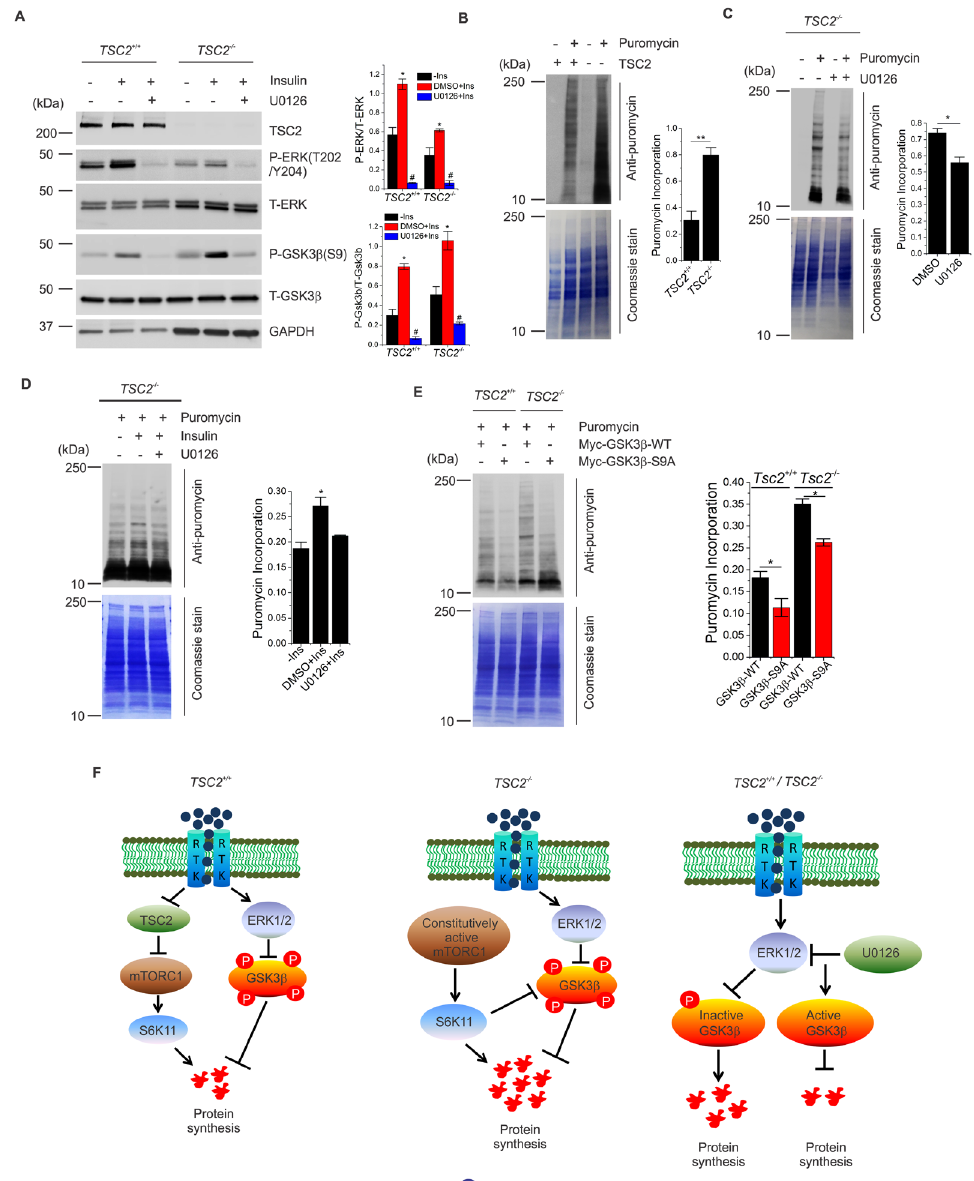
Figure 5. ERK restores GSK3 β activity and protein synthesis levels in Tsc2 − / − cells. ( A ) Tsc2 + / + and Tsc2 − / − MEFs were starved of serum (16 h) and treated with U0126 for 2 h prior to insulin stimulation (1 µ M, 15 min). Lysates were analyzed by immunoblot assay using antibodies as indicated. GAPDH was used as a loading control in all immunoblot assays. Quantification of three independent experiments is reported in the bar diagrams. * and # indicate significant differences between all conditions in each group. ( B ) Tsc2 + / + and Tsc2 − / − MEFs were grown 24 h followed by treatment with puromycin for 30 min prior to cell lysis. ( C ) Tsc2 − / − MEFs were grown 24 h followed by treatment with U0126 for 24 h prior to the addition of puromycin (30 min) in media. Cell lysates from B and C were probed with an antibody to puromycin. The blots were stained with coomassie at the end of the immunoblot assay. Quantification of three independent experiments is reported in the bar diagrams in B and C . ( D ) Tsc2 − / − MEFs were starved of serum (16 h) and treated with U0126 for 2 h prior to insulin stimulation (1 µ M, 15 min). Cells were then incubated with puromycin for 30 min followed by cell lysis. Lysates were probed with an antibody to puromycin. Blot was stained with coomassie at the end of the immunoblot assay. Quantifications of three independent experiments are reported in the bar diagrams. ( E ) Tsc2 + / + and Tsc2 − / − MEFs were transfected with Myc-GSK3 β -WT or Myc-GSK3 β -S9A for 48 h prior to the addition of puromycin in the culture medium. Cell lysates were probed with an antibody to puromycin. The blot was stained with coomassie at the end of the immunoblot assay. Quantitative analyses are reported as mean ± SEM with a significance level of * p < 0.05 and ** p < 0.01 in B , C , D and E . ( F ) Model showing that Tsc2 − / − MEFs have elevated level of protein synthesis compared to Tsc2 + / + MEFs of protein synthesis. ERK integrates insulin signaling to GSK3 β and protein synthesis in both Tsc2 + / + and Tsc2 − / − cells. Inhibition of ERK activates GSK3 β and decreases protein synthesis level. Cropped blots from full-length gels are displayed in A